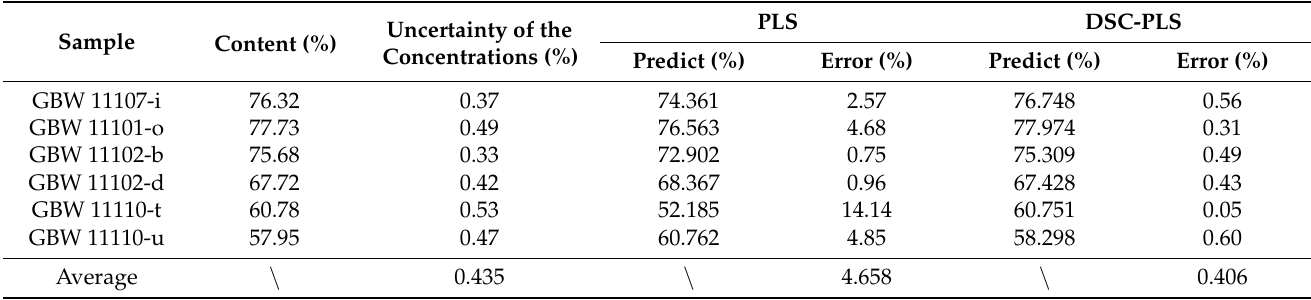
Table 4. The prediction ability of two methods for the carbon content of unknown